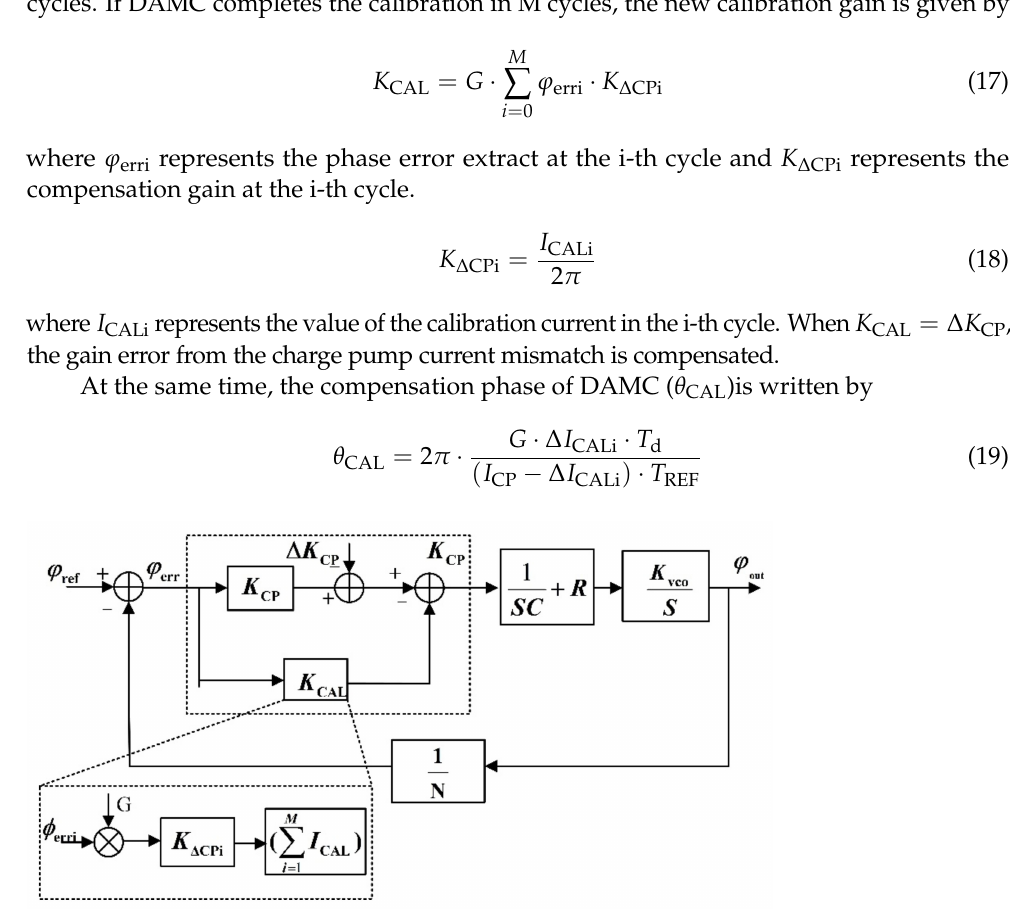
Figure 8. S-domain model of the PLL with DAMC.